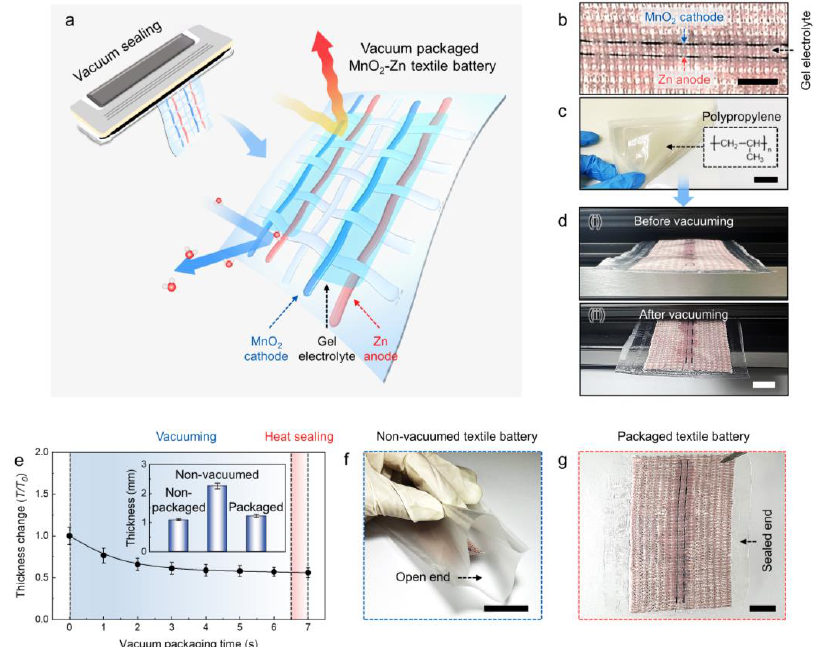
Figure 1. ( a ) Schematic illustration of the vacuum − packaged MnO 2 − Zn textile battery (blue yarns for MnO 2 cathode and red yarns for Zn anode) assembled with a vacuum packaging machine. Optical microscope images showing ( b ) nonpackaged MnO 2 − Zn textile battery and ( c ) polypropylene film used to package the MnO 2 − Zn textile battery (scale bars are 1 and 2 cm, respectively). ( d ) Actual images of the textile battery ( i ) before and ( ii ) after vacuum packaging (scale bar = 2 cm). ( e ) Measured thickness changes ( T / T 0 ) versus vacuum packaging time until heat sealing ( T 0 represents the thick- ness of the nonvacuumed textile battery); the inset graph shows the thicknesses of the nonpackaged, nonvacuumed, and packaged textile batteries. Optical photographs of the ( f ) nonpackaged (before vacuuming and heat sealing) and ( g ) packaged (after vacuuming and heat sealing) battery (scale bars are 3 and 1 cm,